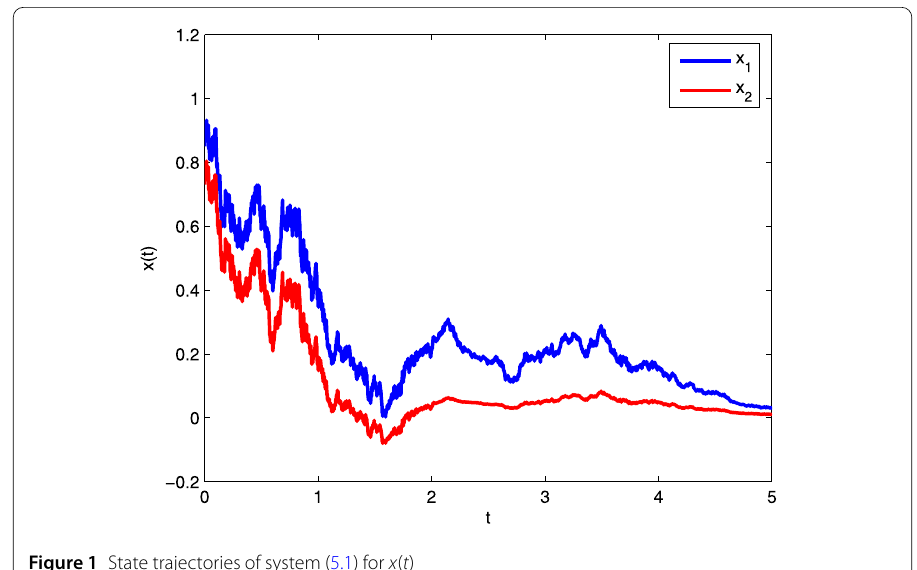
Figure 1 State trajectories of system (5.1) for x ( t